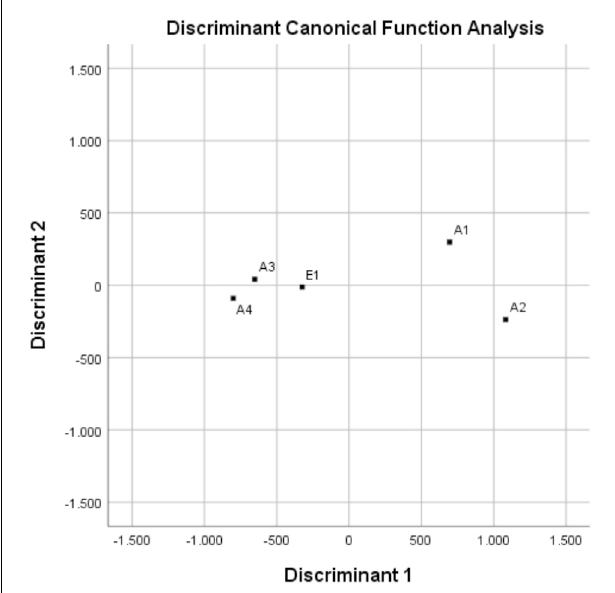
FIGURE 4 | Discriminant canonical function analysis of data sets for chars A1, A2, A3, A4, and E1, derived from different feedstocks and processes.